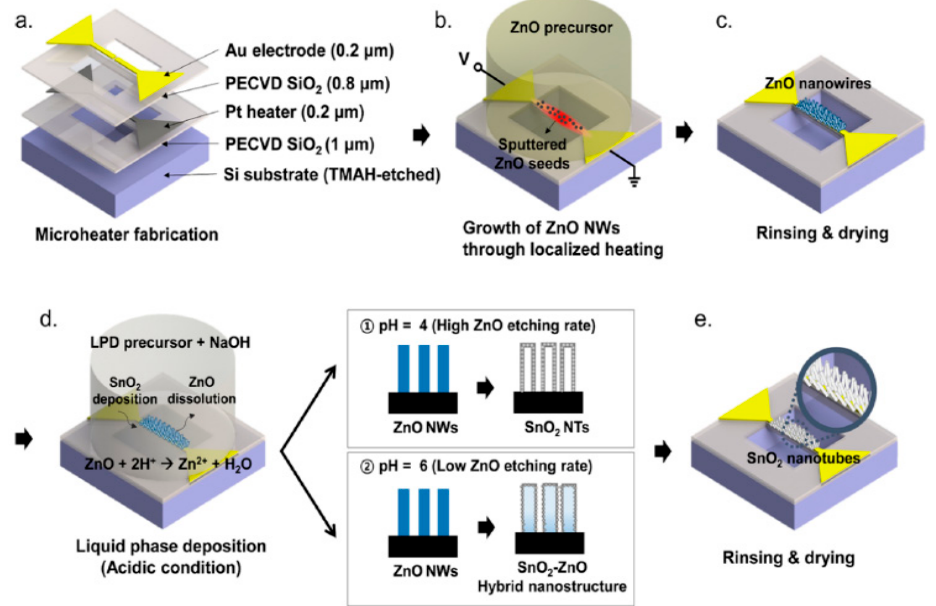
Figure 8. ( a ) Structural diagram of the micro-hotplate; ( b , c ) ZnO nanowires synthesized by hydro- thermal method; ( d , e ) locally synthesized ZnO nanowires replaced by SnO 2 nanotubes (PH = 4) by liquid deposition method or SnO 2 /ZnO composite structure (PH = 6) [64].